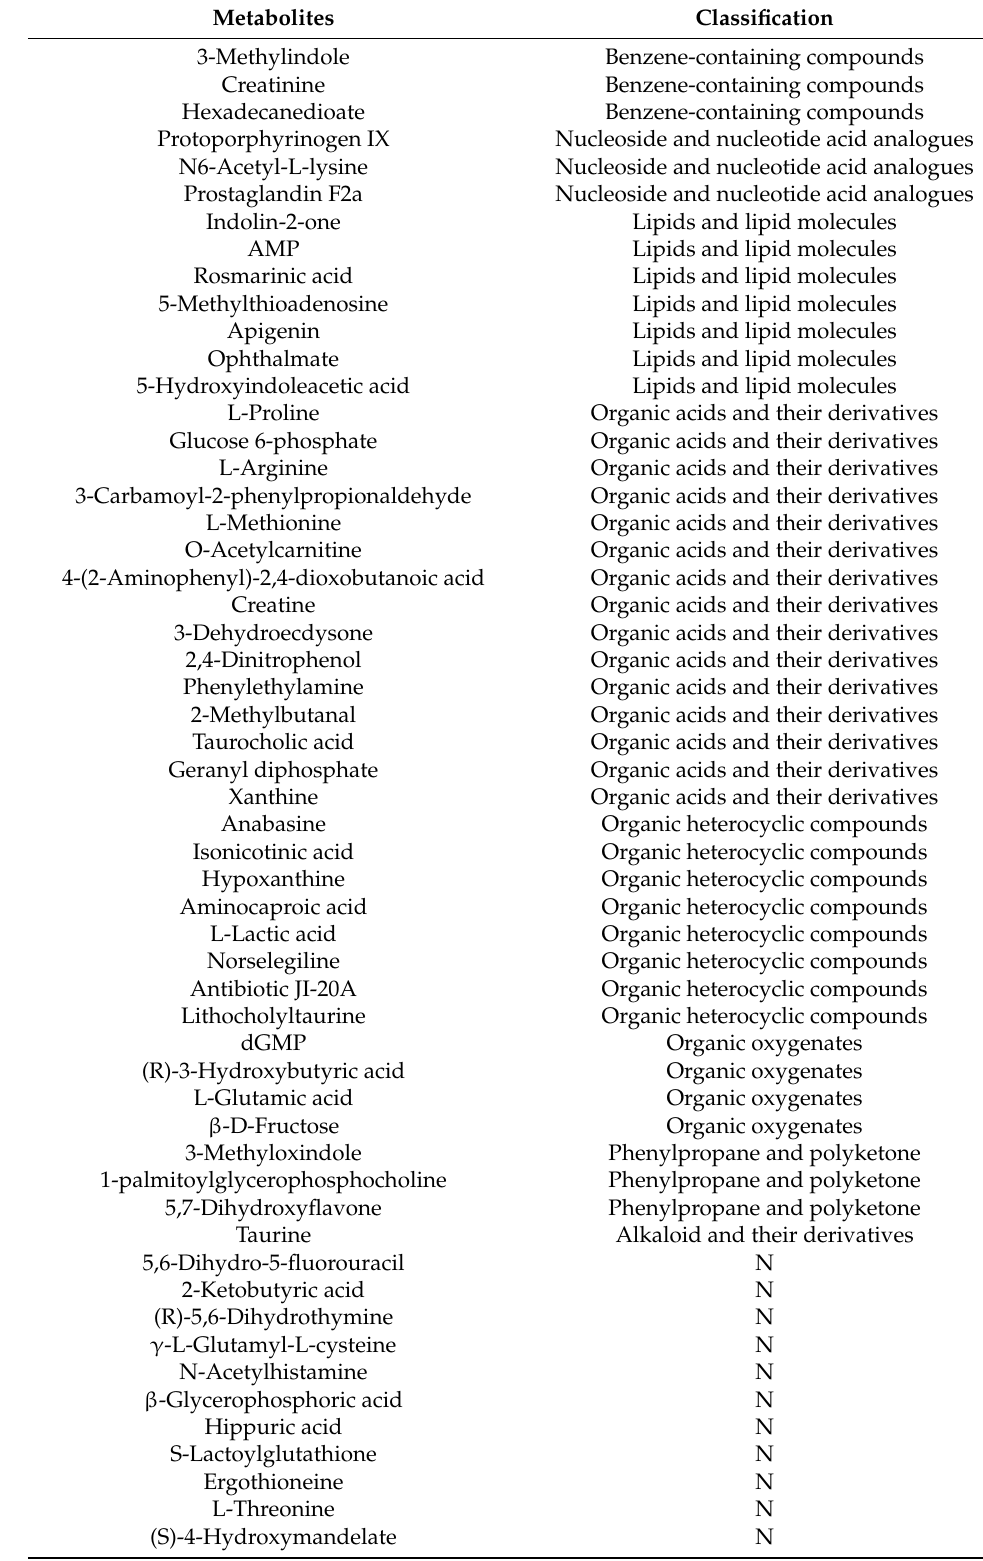
Table 7. Basic information of different metabolites identified in leg